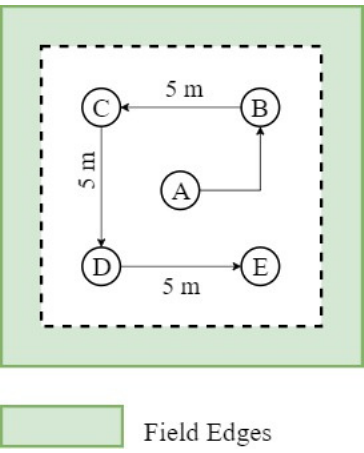
Figure 2 . LAI Measurements: ( a ) Data inputs to the SS1 SunScan Canopy Analysis System, ( b ) beam fraction sensor (BFS) installed in a potato field.